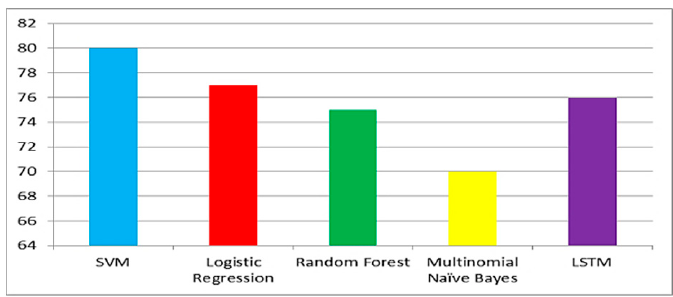
Figure 8. Model accuracy comparison for the healthcare service provider query.